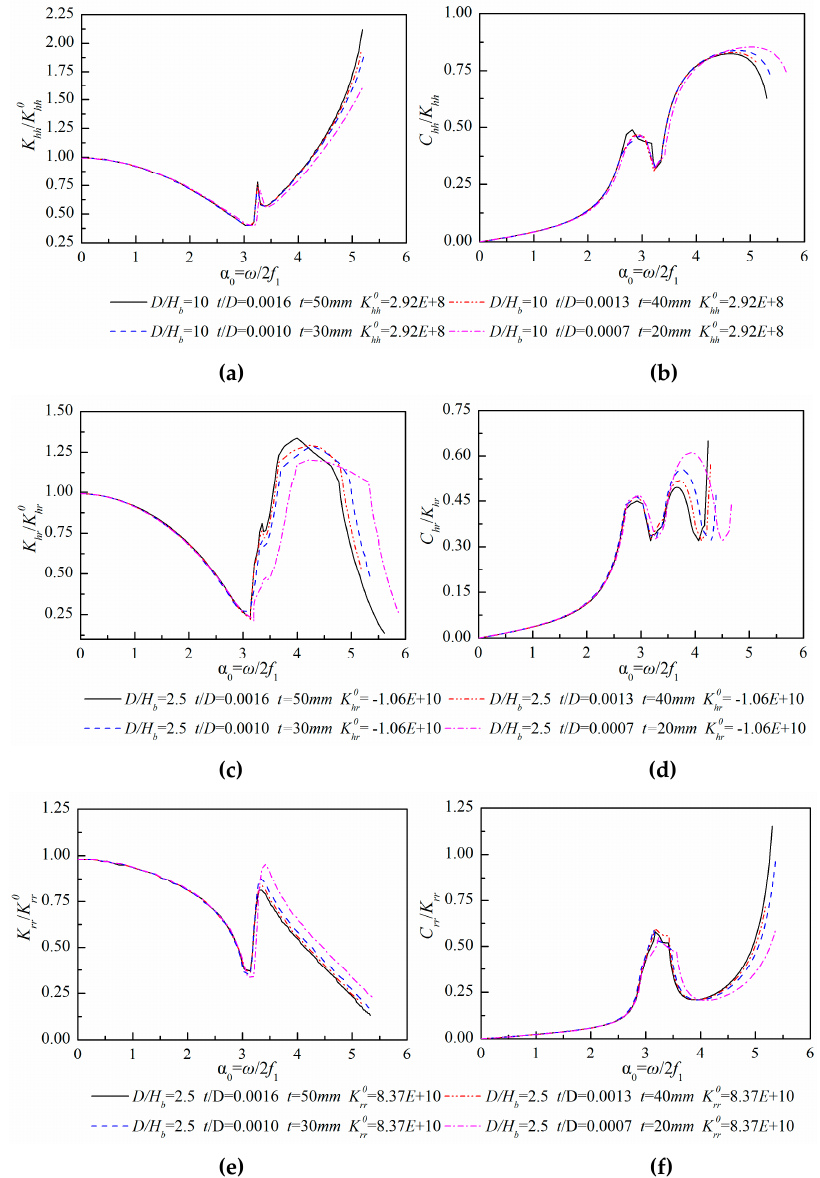
Figure 11. Variation of three dynamic impedance coe ffi cients with respect to the dimensionless frequency under di ff erent skirt thickness: ( a ) Horizontal sti ff ness coe ffi cient; ( b ) horizontal damping coe ffi cient; ( c ) coupling sti ff ness coe ffi cient; ( d ) coupling damping coe ffi cient; ( e ) rocking sti ff ness coe ffi cient; ( f ) rocking damping coe ffi